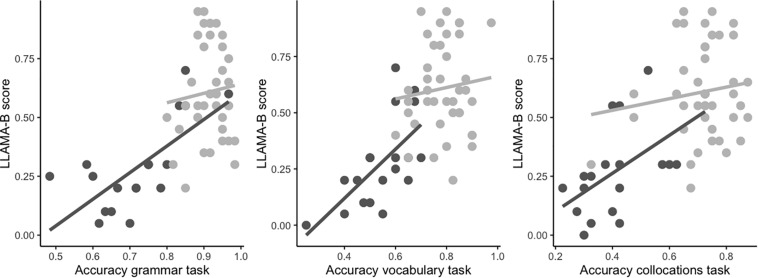
Scatterplots of individual values for LLAMA-B scores and individual scores for Grammar (left), Vocabulary (center), and Collocations (right) by Group (LAA – in dark gray; HAA – in light gray). Regression lines for each group are provided for illustration purposes.